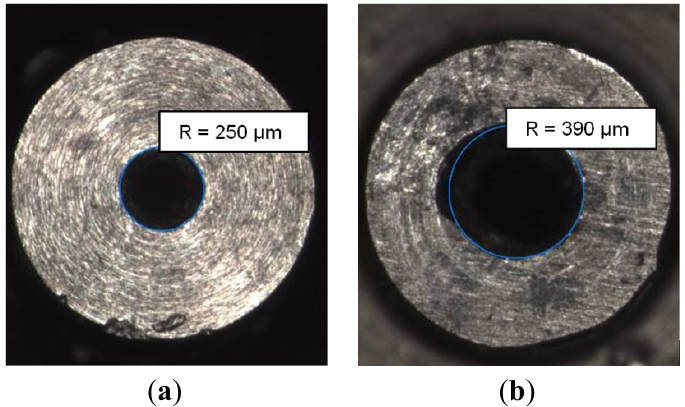
Figure 2. Top view: reservoir outlet tube (ROT) of the StarJet V1 device before ( a ) R = 250 μ m and after ( b ) R = 390 μ m operation at T = 230 °C using solder